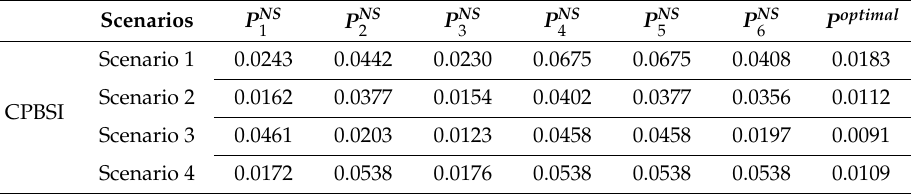
Table 9. Stability analysis of di ff erent allocation schemes under di ff erent scenarios in